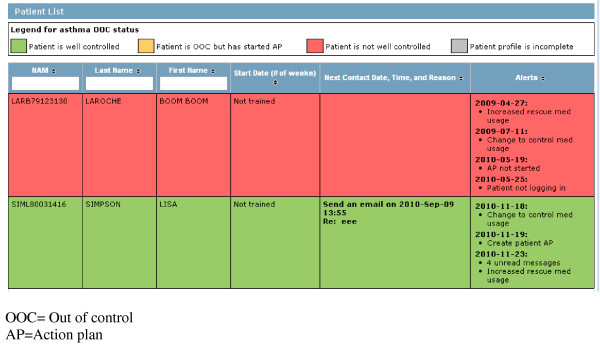
Nurse Case-Management Triage Patient List. OOC = Out of control. AP = Action plan.